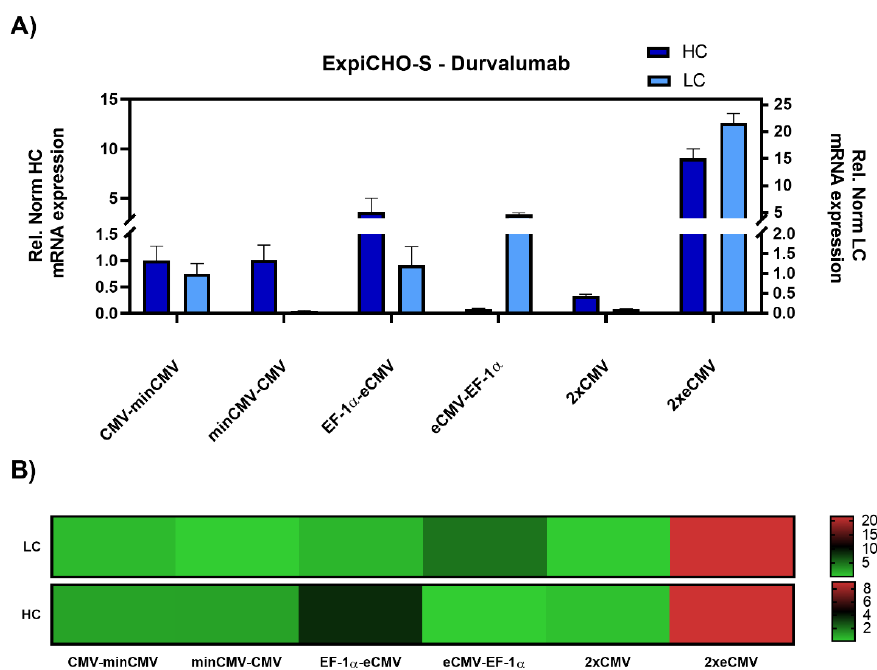
Figure 4. Gene expression analysis of heavy and light chain genes after transient transfection of Durvalumab in ExpiCHO-S cells. ( A ) Bar chart representing heavy (dark blue) and light (light blue) chain mRNA expression in the different constructs. Values are relative to the CMV-minCMV construct and normalised to housekeeping genes GAPDH and RPLP0. Error bars represent the standard error of the mean of technical triplicates. ( B ) Heat map representation of gene expression analysis. The relative normalised gene expression for light and heavy chain mRNA is shown on the right with their respective scales.